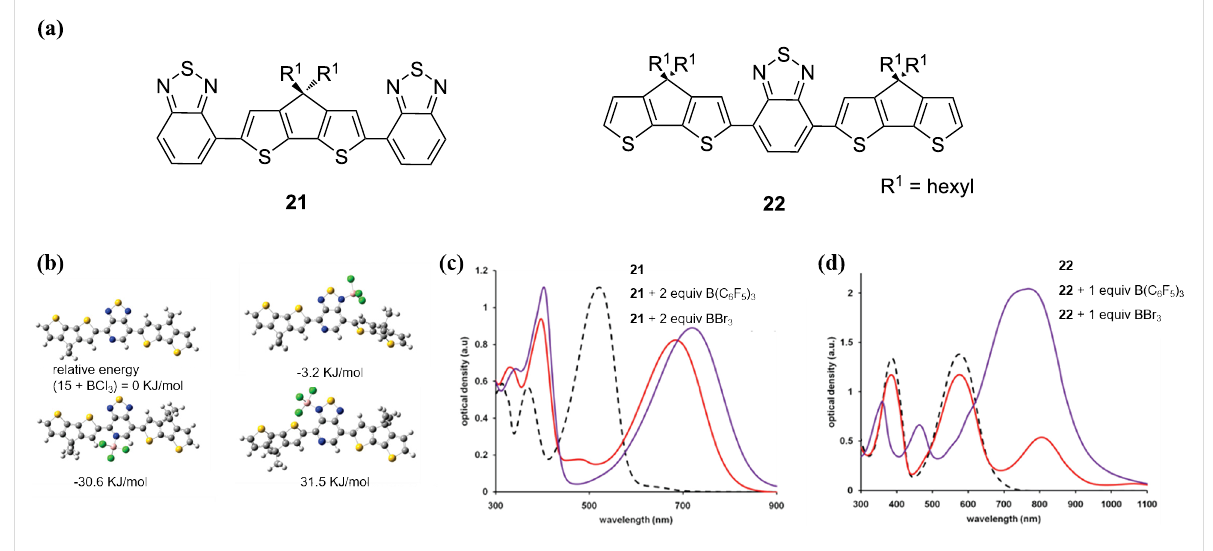
Figure 13: (a) Schematic diagram of the low-band gap materials 21 and 22 . (b) Ground state geometry optimizations of compound 15 and its corre- sponding adducts with BCl 3 . The optimized structures were calculated using DFT at the B3LYP/6-31G (d,p) level of theory. UV–vis–NIR absorption spectra of (c) compound 21 and (d) compound 22 before and after adding the Lewis acids B(C 6 F 5 ) 3 and BBr 3 in o -DCB solution, respectively. Figure 13b–d were reprinted with permission from [43], Copyright 2011 American Chemical Society. This content is not subject to CC BY